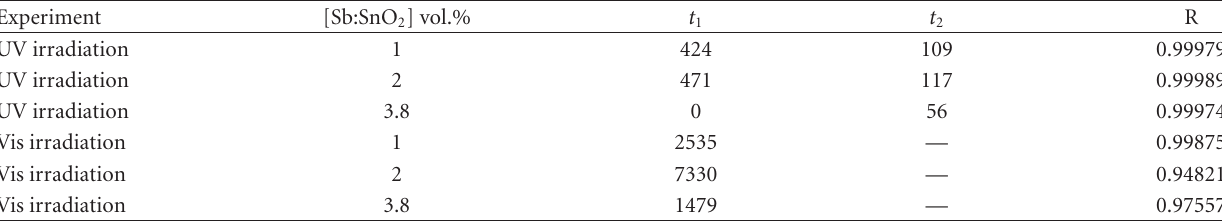
Table 2: Exponential curve fitting of the ratio of σ/σ 0 over